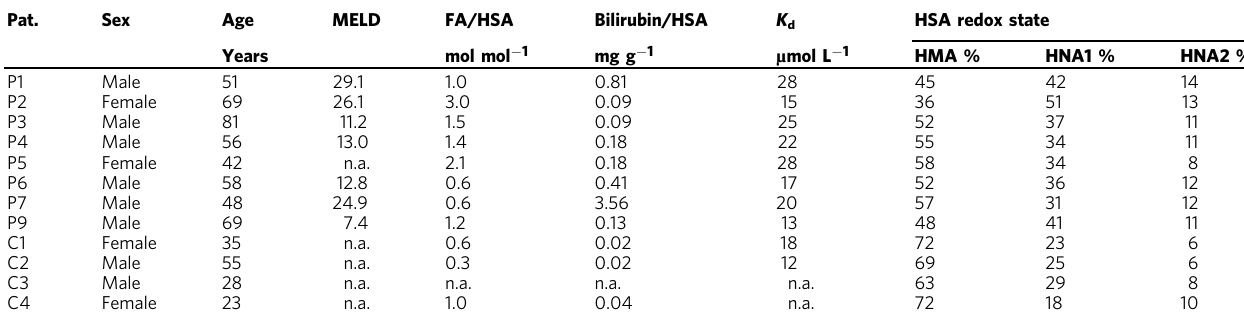
MELD model for end-stage liver disease, FA fatty acids, n.a. not